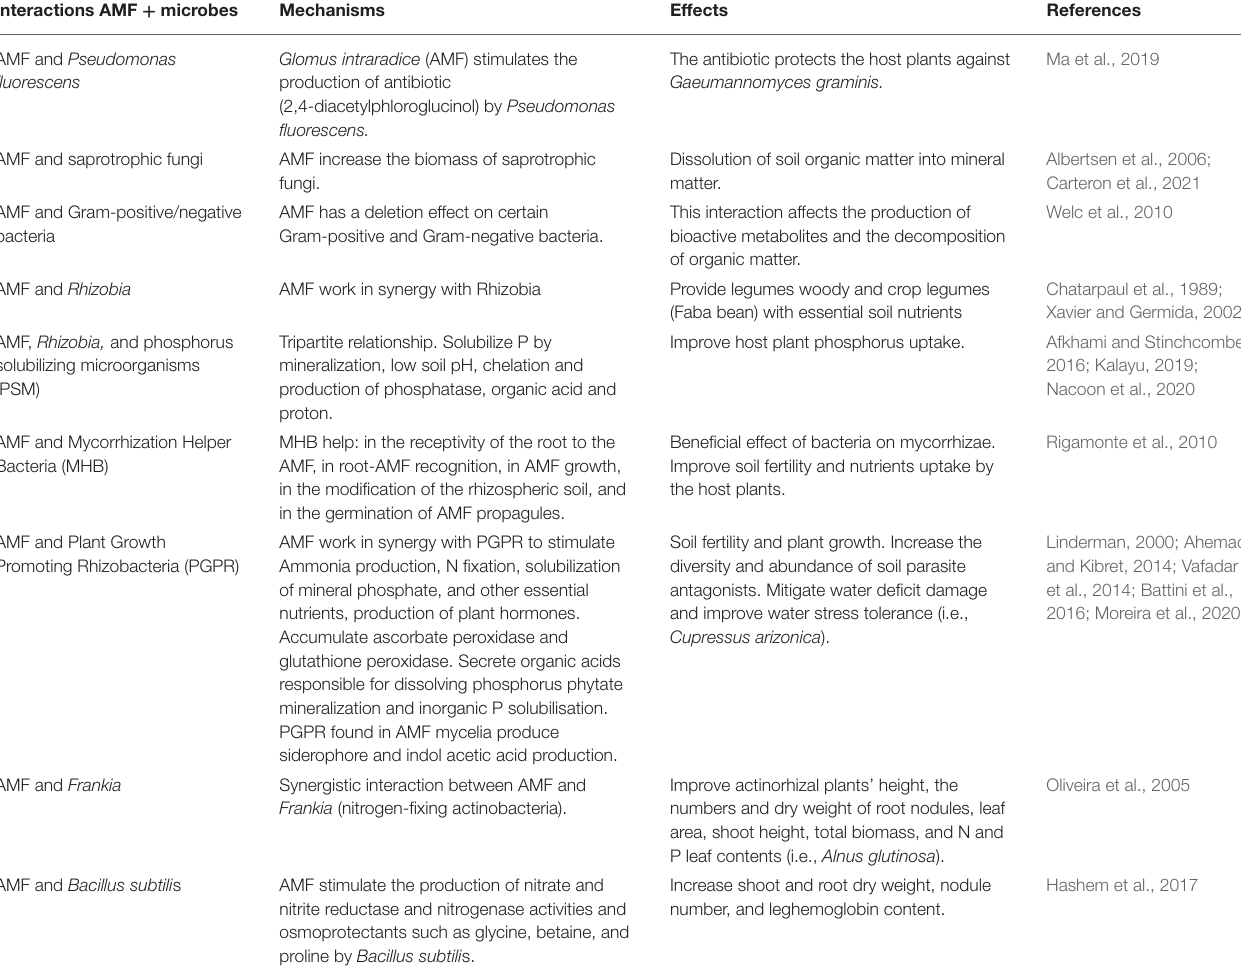
TABLE 1 | Examples of some interactions between AMF and soil